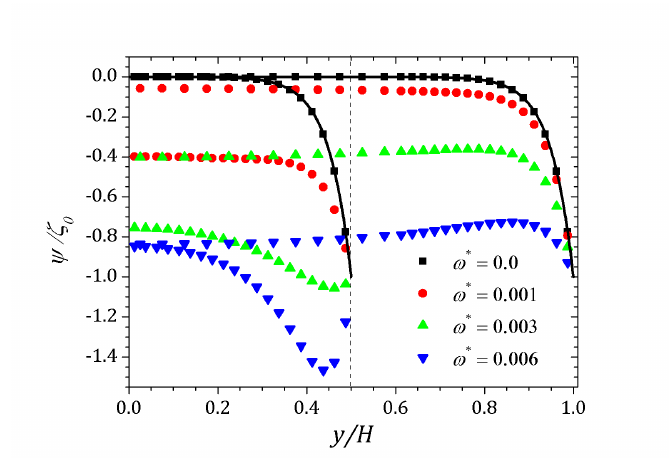
Figure 21. Potential ψ into the contraction and right after the expansion of the channel. Results for perturbation parameter ω ∗ = 0 , 1.0 × 10 − 3 , 3.0 × 10 − 3 and 6.0 × 10 − 3